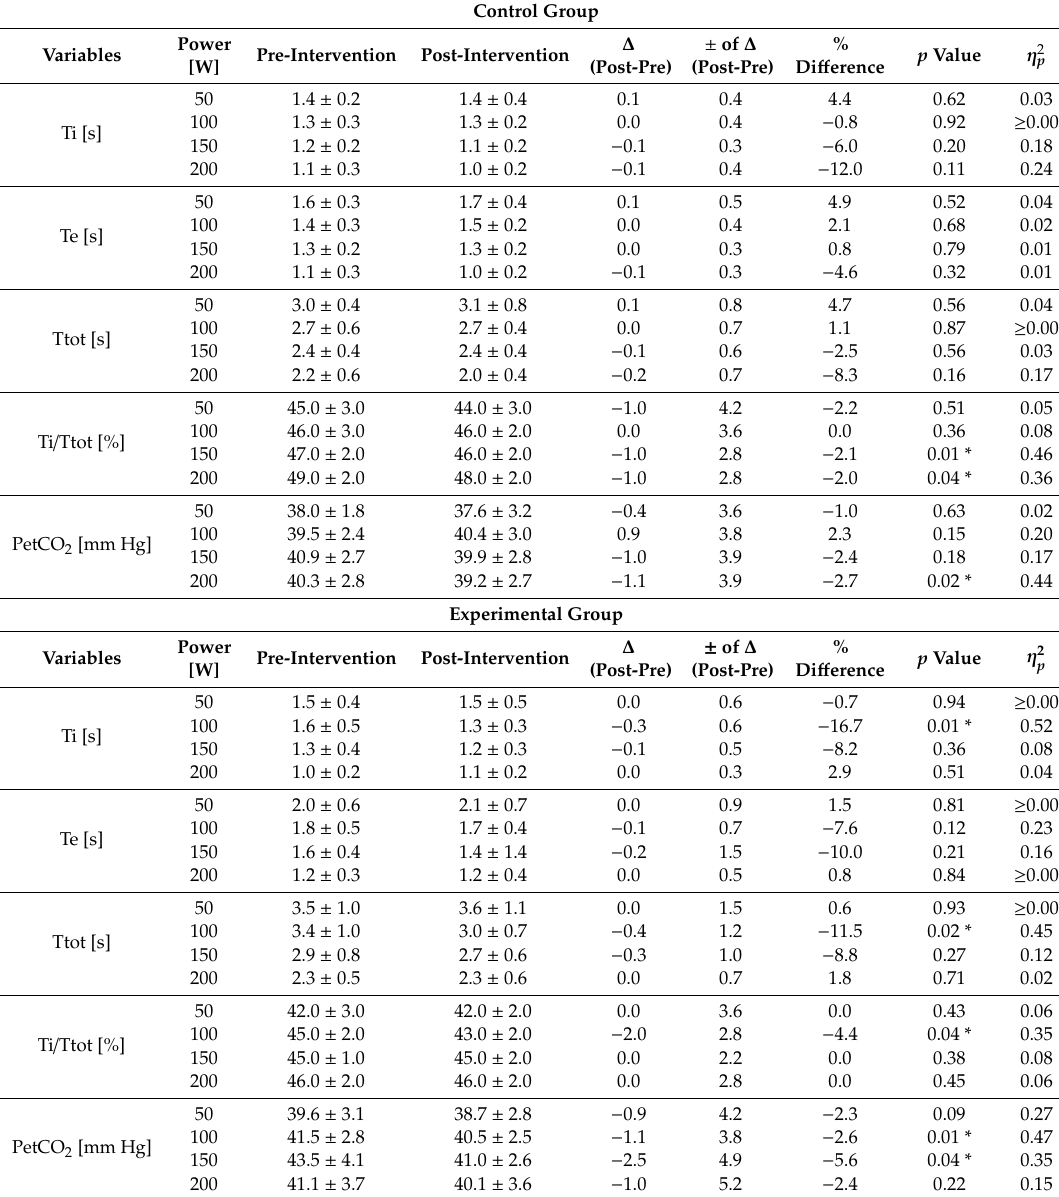
Table 4. Pre- and postintervention within-group comparisons (Ti, Te, Ttot, Ti / Ttot, PetCO 2 ).